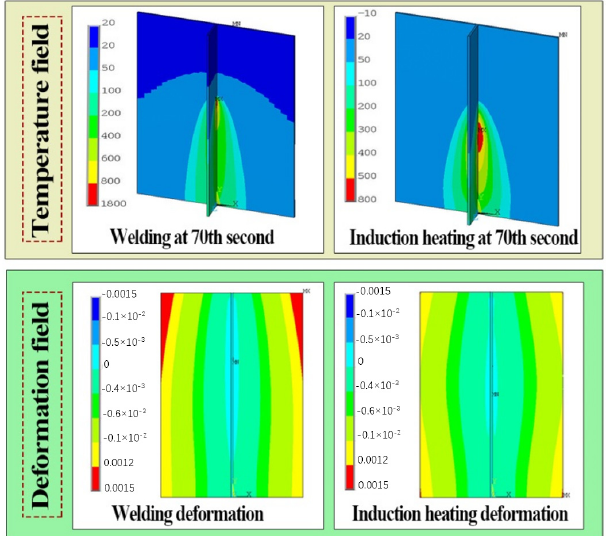
Figure 15. Temperature and deformation distribution based on re-defined element attributes method (5 mm).